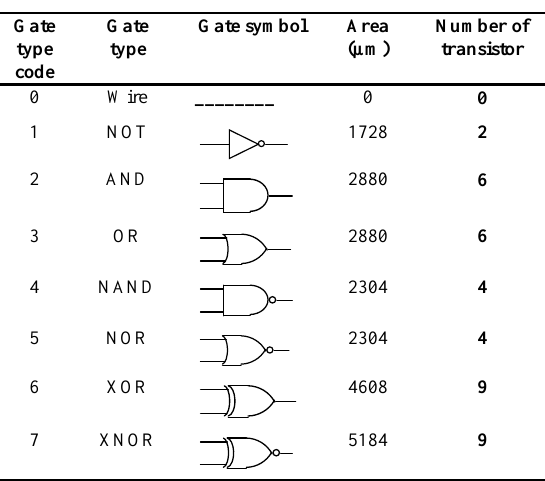
Table 1. CMOS gate characteristics.